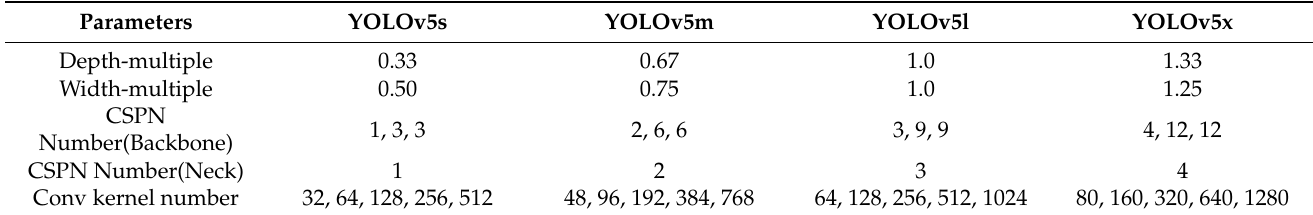
Table 1. Parameters of the YOLOv5 series network structure.